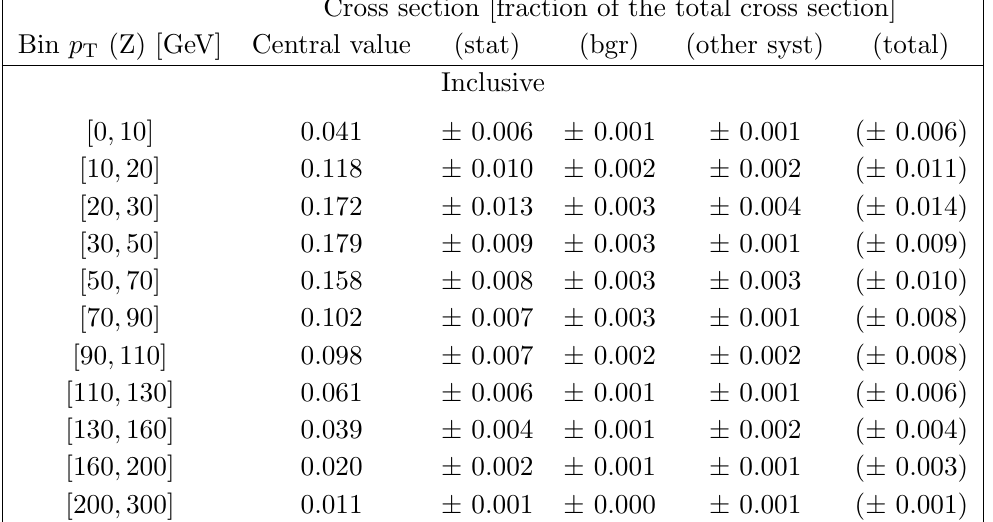
Table 9 . Di(cid:11)erential cross section in bins of p T (Z). Values are expressed as a fraction of the total cross section. The inclusive (cid:12)nal state is shown.